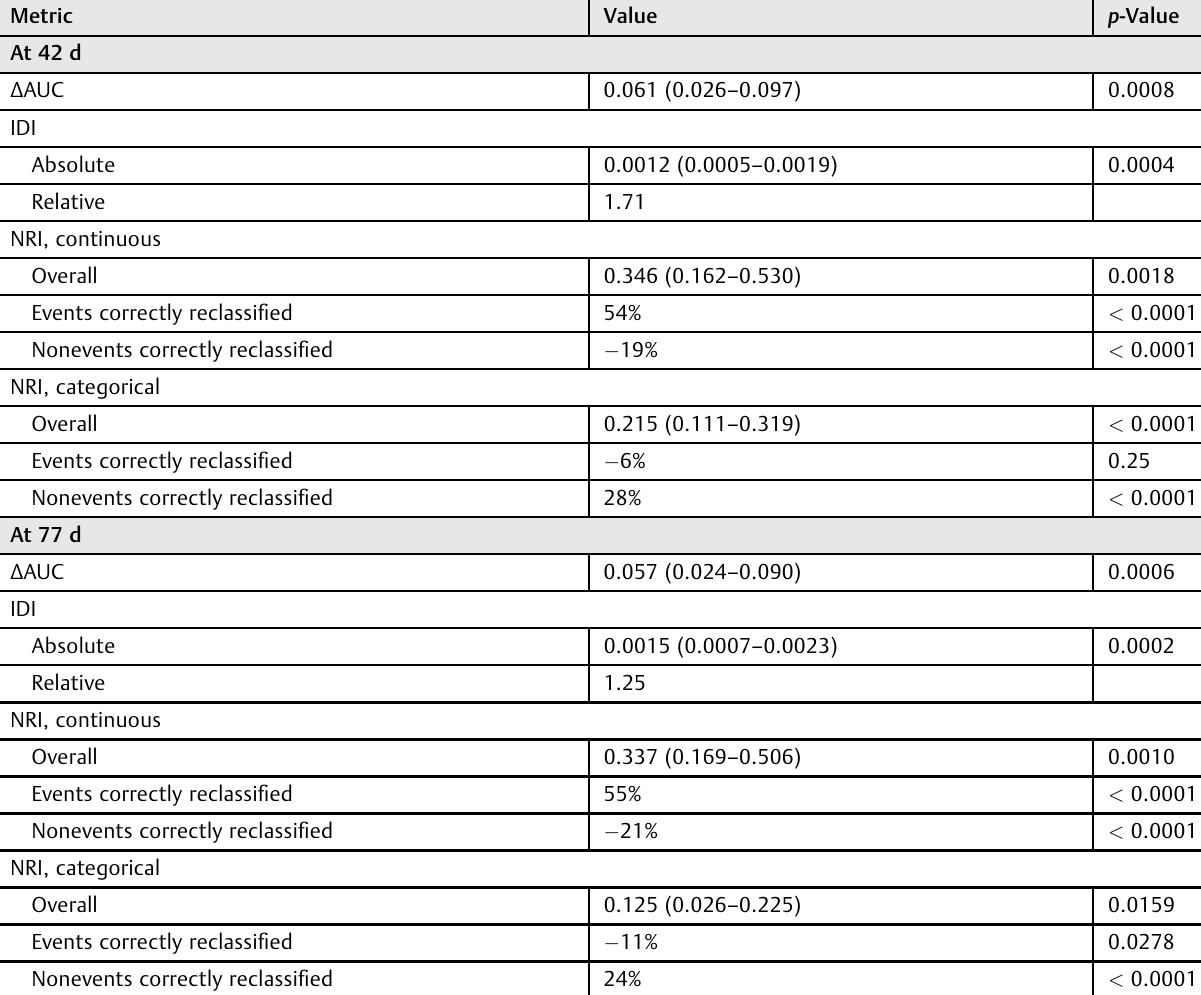
Table 4 Improvement in model performance by the IMPROVEDD VTE risk